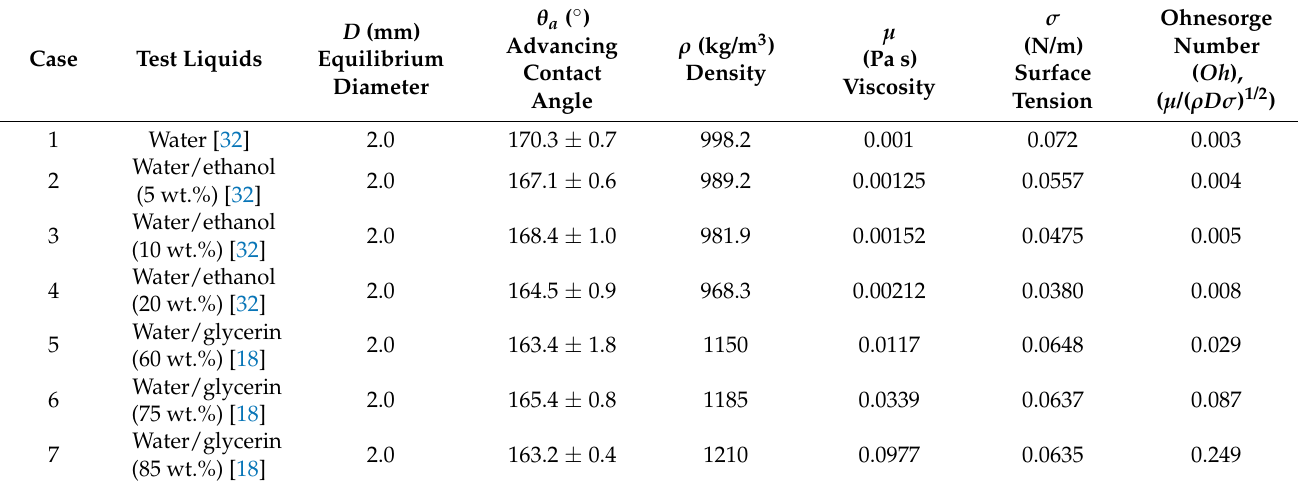
Table 1. Liquid properties used in the